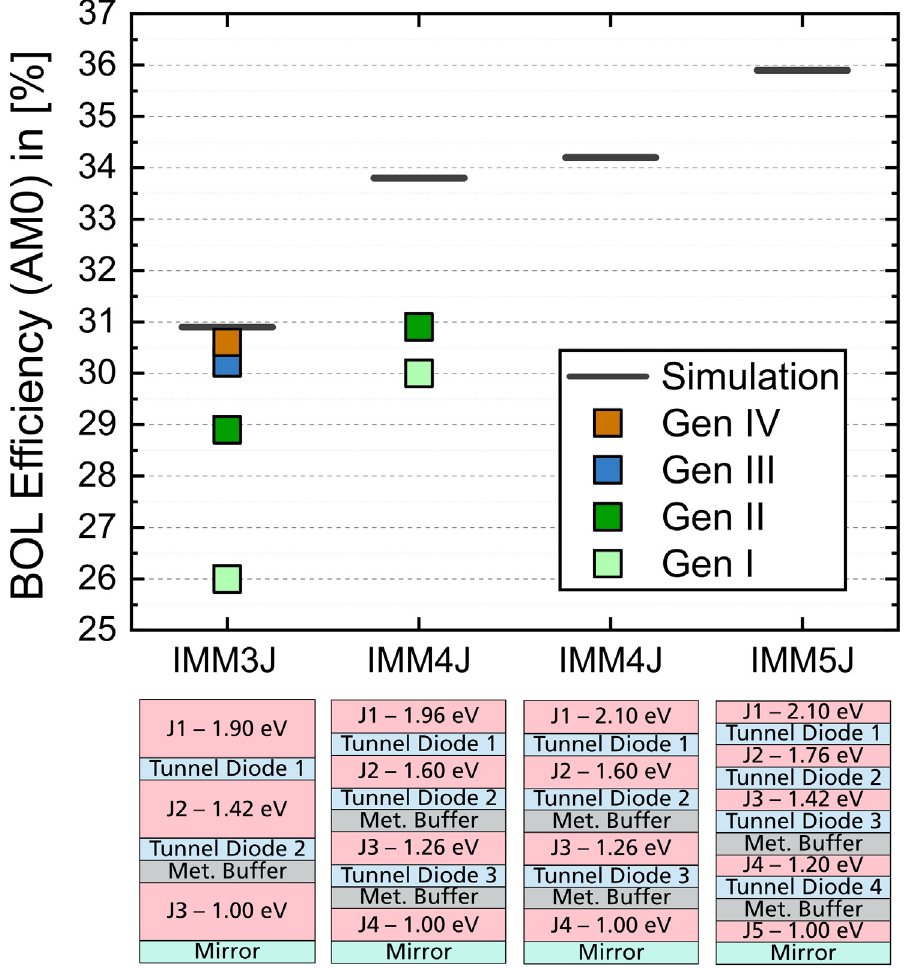
Fig. 1. Development steps from an IMM 3J solar cell towards an IMM5J solar cell with BOL design. For comparison, the simulated near-term ef fi ciency potential and the already achieved ef fi ciencies for the IMM3J and IMM4J are shown. Keep in mind that the IMM3J is optimized for EOL conditions, whereas the 4J and 5J structures for BOL. The sketch of the layer structure shows schematically that increasing the number of junctions is not increasing the total epitaxy thickness heavily. Note that for an IMM4J cell with top subcell bandgap up to 2.1eV, all other absorber material bandgap energies stay the